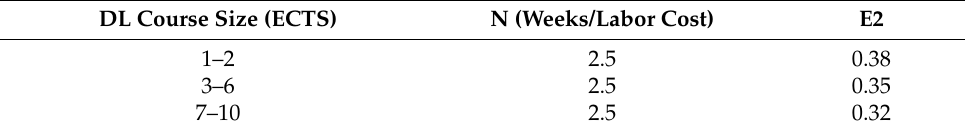
Table 4. The table of ratios for the basic formula